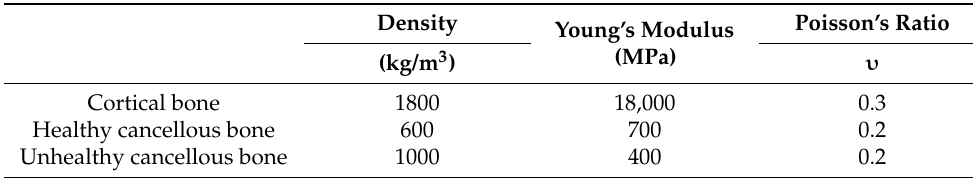
Figure 3. Structure of the tibial bone: ( A ) Cancellous bone, ( B ) Cortical bone. After constructing the tibial bone model, the virtual model of the knee prosthesis was made, consisting of a polyethylene spacer (Figure 4A), tibial component (Figure 4B), and tibial extension (Figure 4C) [2].